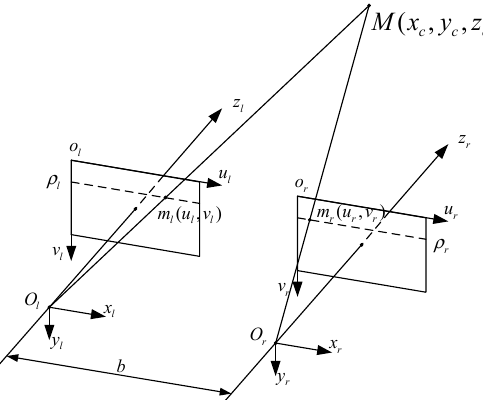
Figure 4. Schematic diagram of binocular parallel stereo vision.